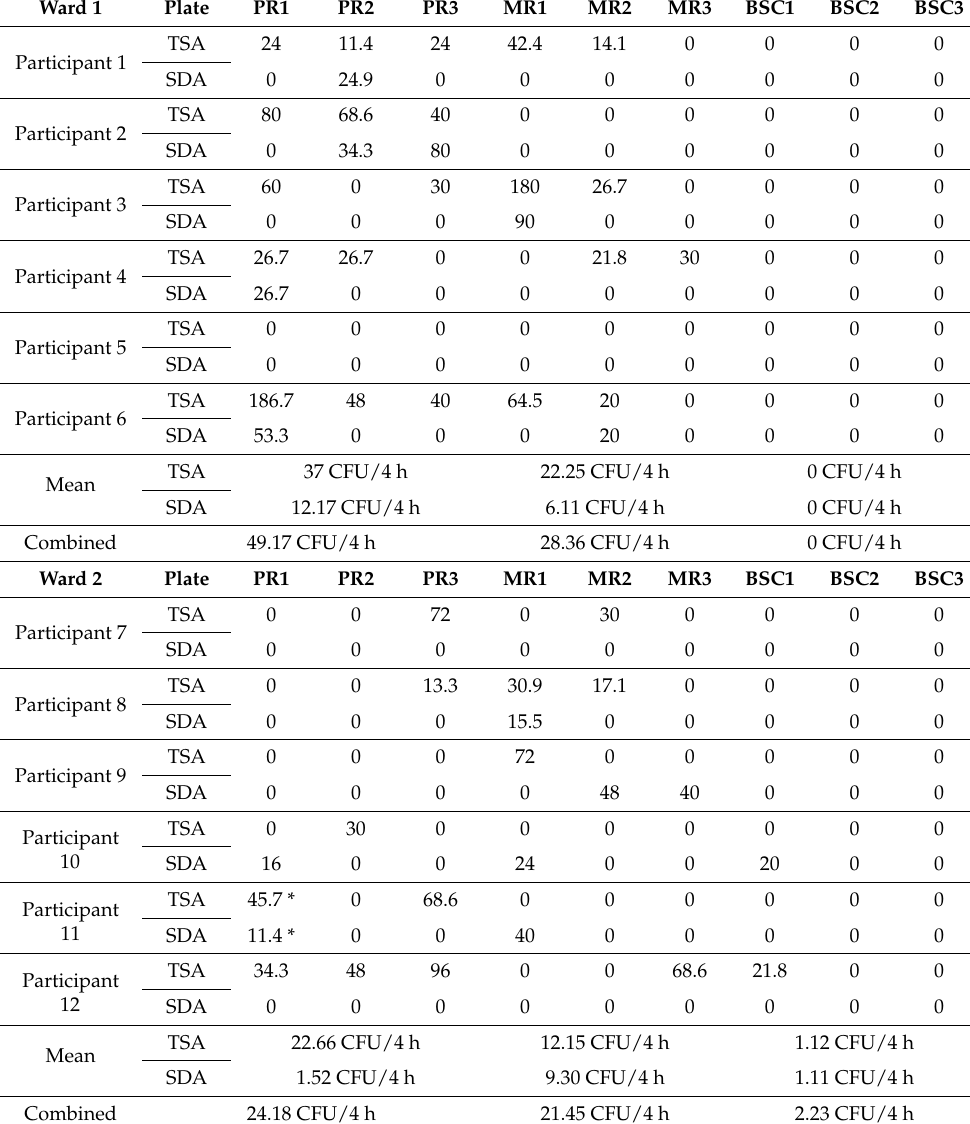
Table 2. Microbial growth (CFU/4 h) on the settle plates, TSA (N = 108) and SDA (N = 108), during the compounding of parenteral product samples in the three different environments in hospital